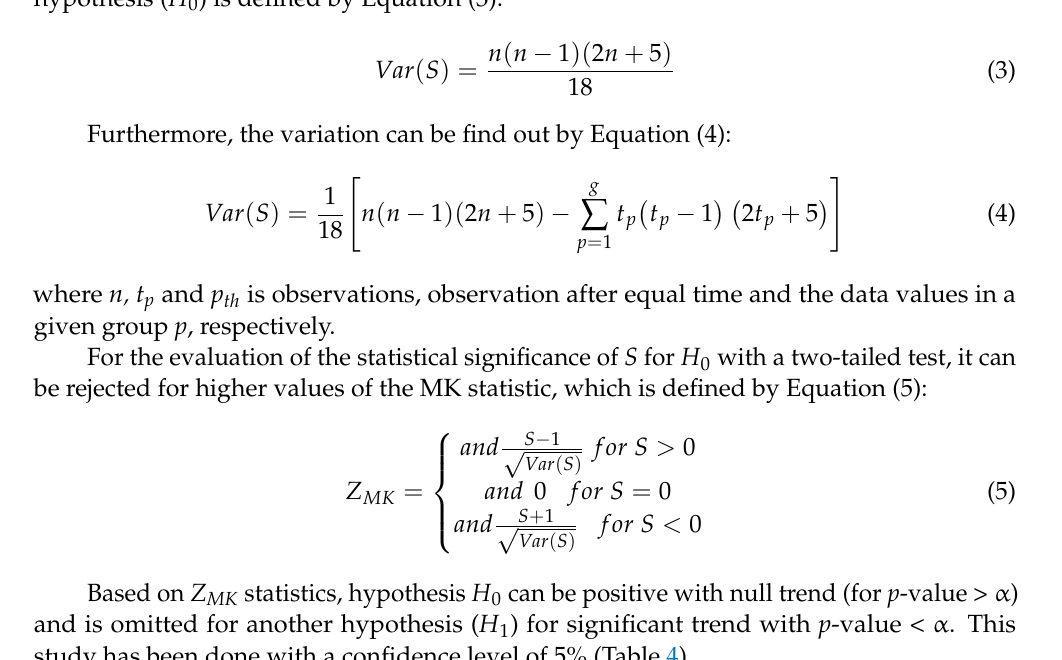
Table 4. The significant Z MK values in the probability range from − 1.96 to +1.96. Category Scale Significant trend of increase (STI) Z MK > +1.96 Non-significant increasing trend